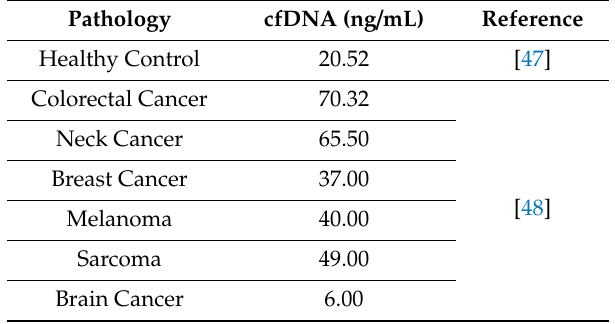
Table 1. Summary of mean concentration of cfDNA on di ff erent types of